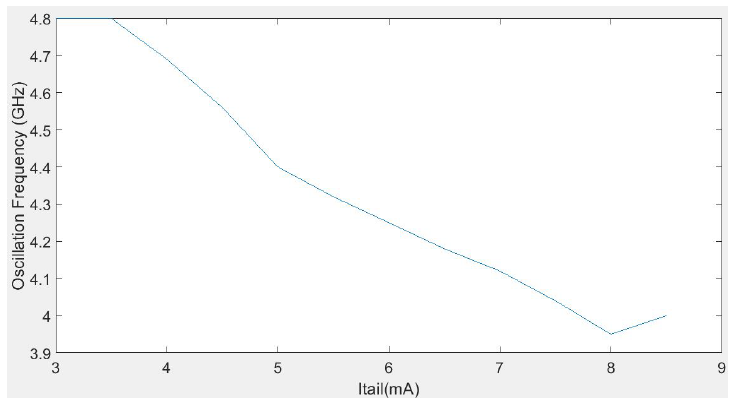
Figure 13. Oscillation frequency vs. tail current @ V ctrl = − 0.55 V.